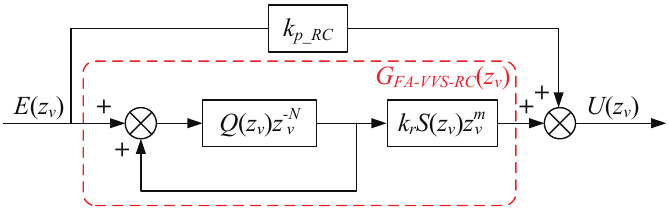
Figure 4. Plug-in IMFA-VVS-RC